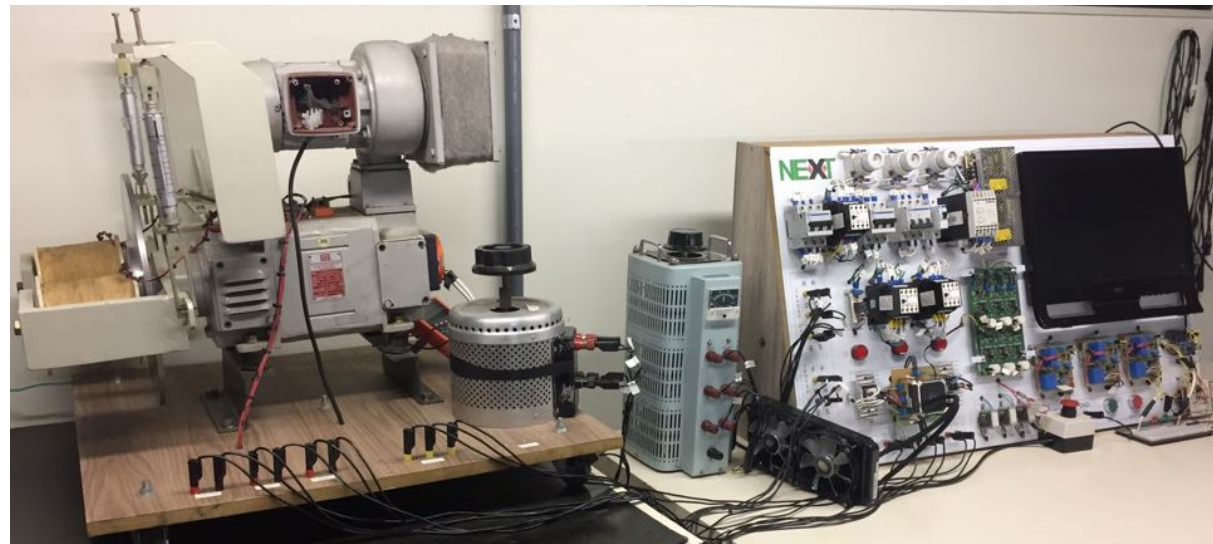
Figure 5. Workbench with the implemented